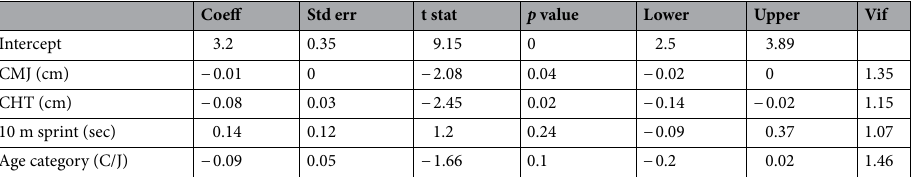
Table 3. Multiple linear regression (dependent variable: 90° COD test time); independent variable: countermovement jump (CMJ) height, cross-over hop test (CHT) distance; 10 m sprint time (sec) and